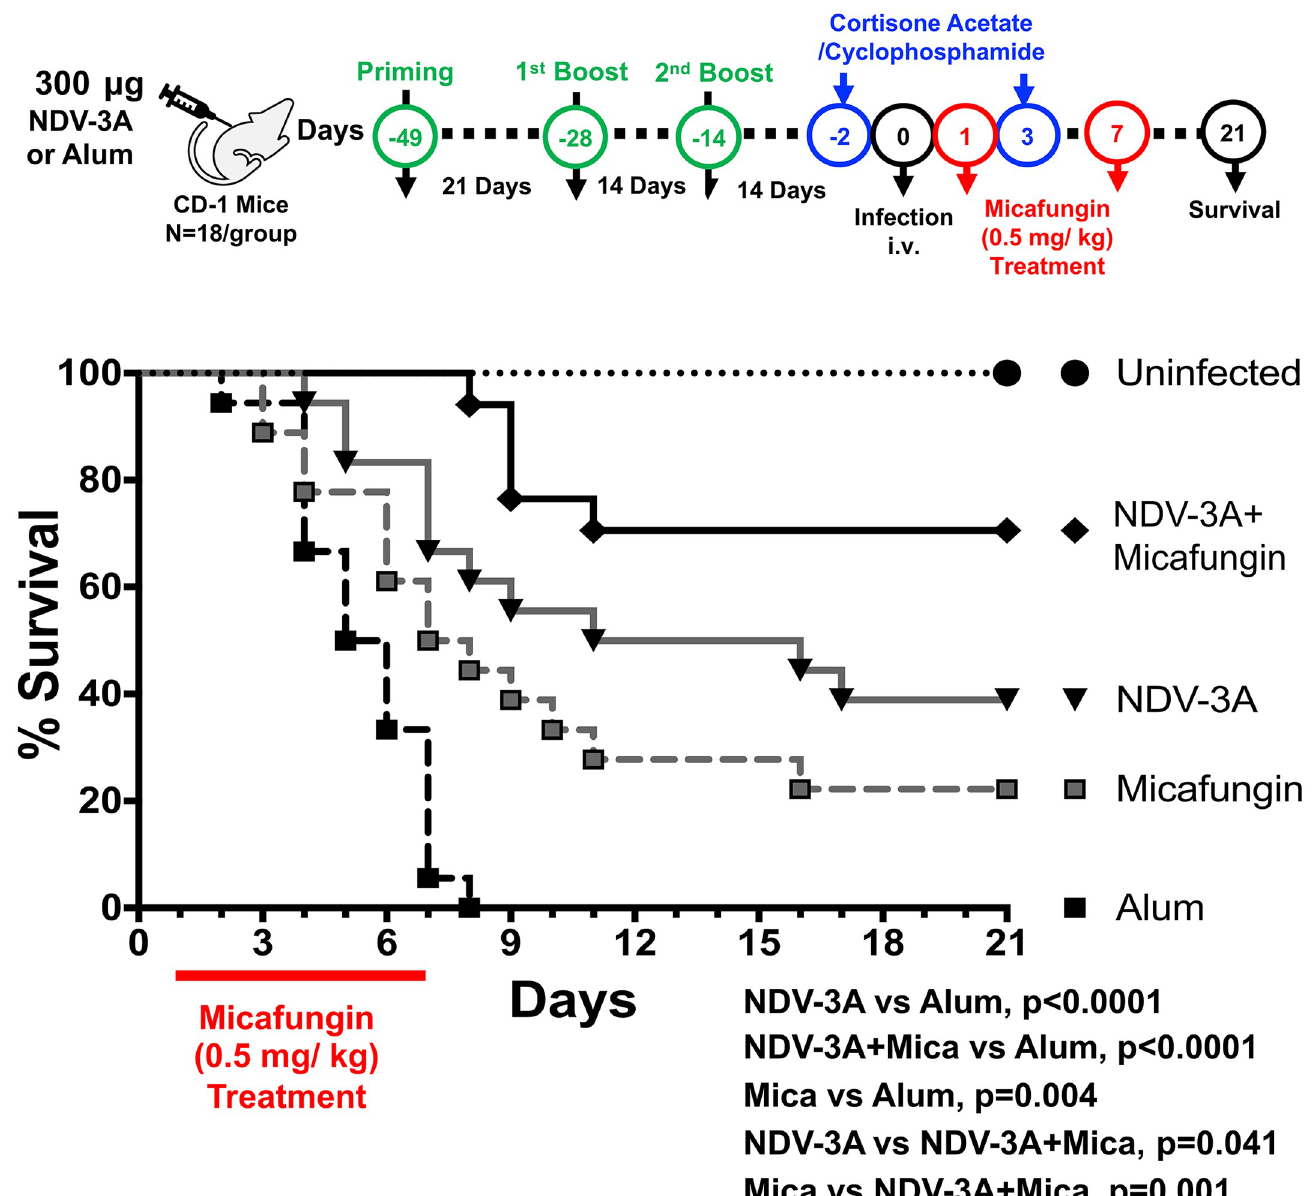
Fig 8. Combination of micafungin and NDV-3A vaccine additively protect neutropenic mice from C . auris bloodstream infection. NDV-3A- or alum control- vaccinated mice were made neutropenic and infected with C . auris . The mice were divided into four groups: NDV-3A vaccine alone, micafungin treatment alone, NDV-3A vaccine + micafungin, alum alone (n = 18 per group from two independent experiments). The mice were evaluated for their survival for 21 days. Both NDV-3A vaccine and micafungin treatment group showed significantly higher survival compared to alum control group. The NDV-3A +micafungin treatment showed further enhanced survival compared to NDV-3A or micafungin treatment alone mice. The mice survival was compared by using Mantel-cox Log-rank Test. The p values < 0.05 was considered